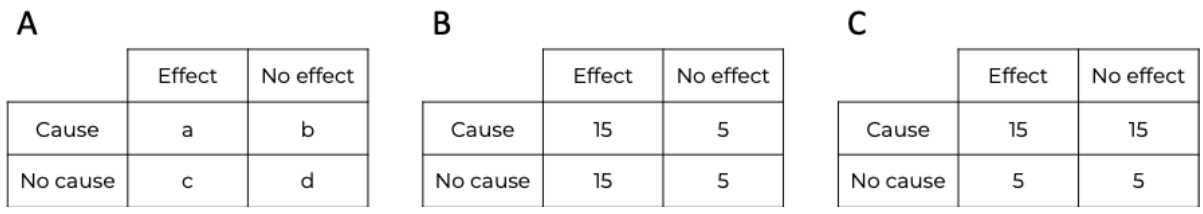
Figure 1. Contingency matrices where (A) shows the four information types as a function of whether the cause and the effect are present, (B) shows an example with a high probability of the effect with null contingency, and (C) shows an example with a high probability of the cause with null